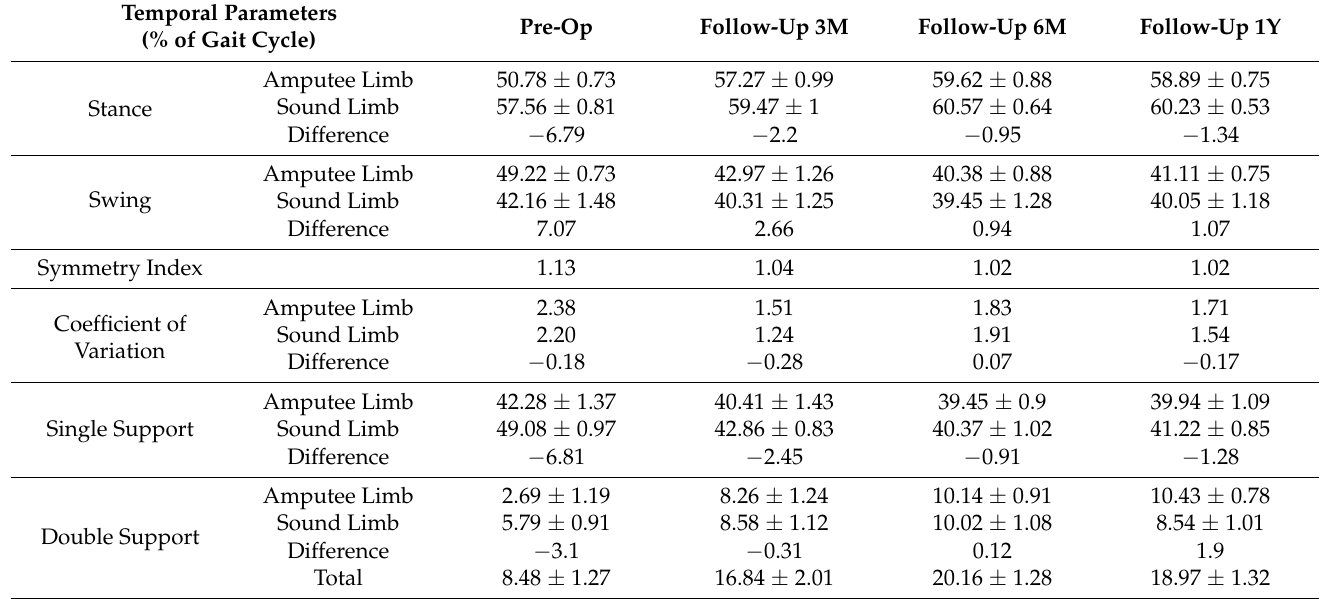
Table A2. Temporal gait parameters for the pre-operative gait analysis (socket-type prosthesis, ST) and the follow-up gait analyses (osseointegrated prosthesis, OI). Data are presented for the self- selected speed gait as mean ± standard deviation in percentage of the gait cycle. Note: “Difference” means Sound limb—Amputee limb variable; symmetry index = 1.00 means perfect symmetry between stance phases of the two